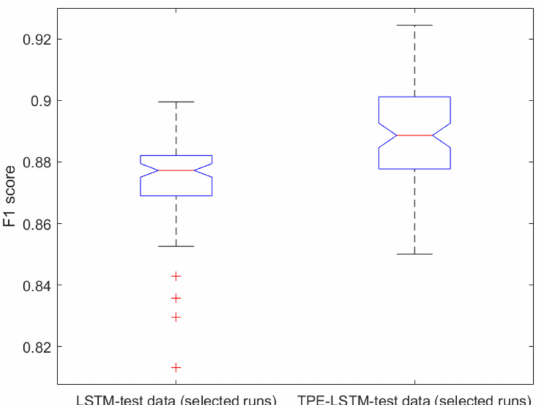
Figure 7. F1 score: test data, 86% runs with improvement applied. LSTM versus TPE-LSTM.